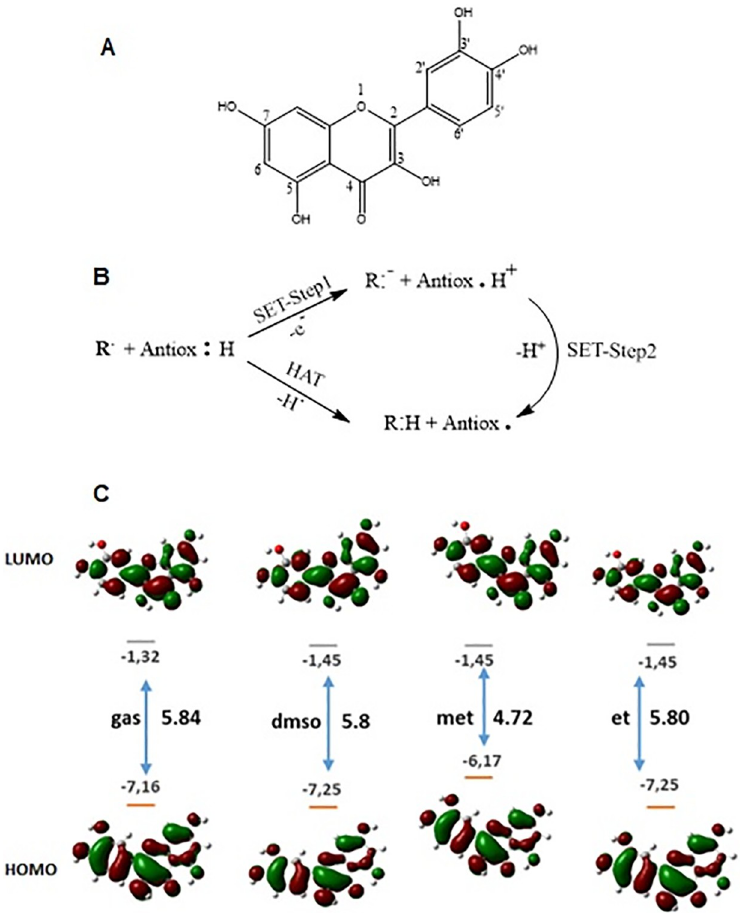
Fig 6. 2D structure visulalization and numbering of the atom of the quercetin molecule (A). Two mechanisms of antioxidant, SET and HAT [Liang, N; 2014] (B). HOMO-LUMO energies(eV) and distribution for quercetin in the gas, DMSO, ethanol and methanol solvents (C).